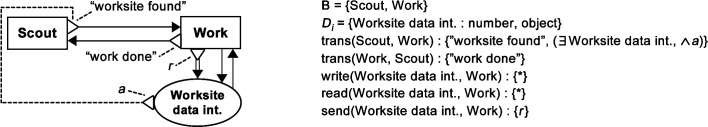
 BDRML representation of the Broadcaster design pattern.